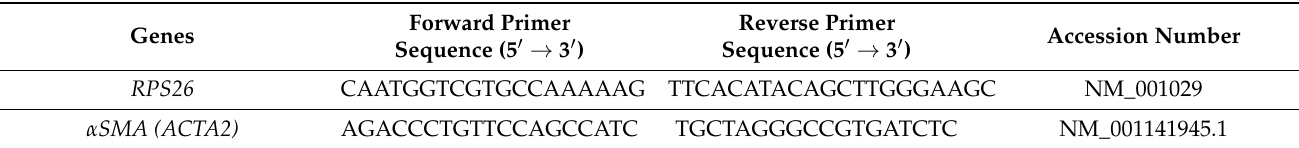
Table 1. RT-qPCR primer